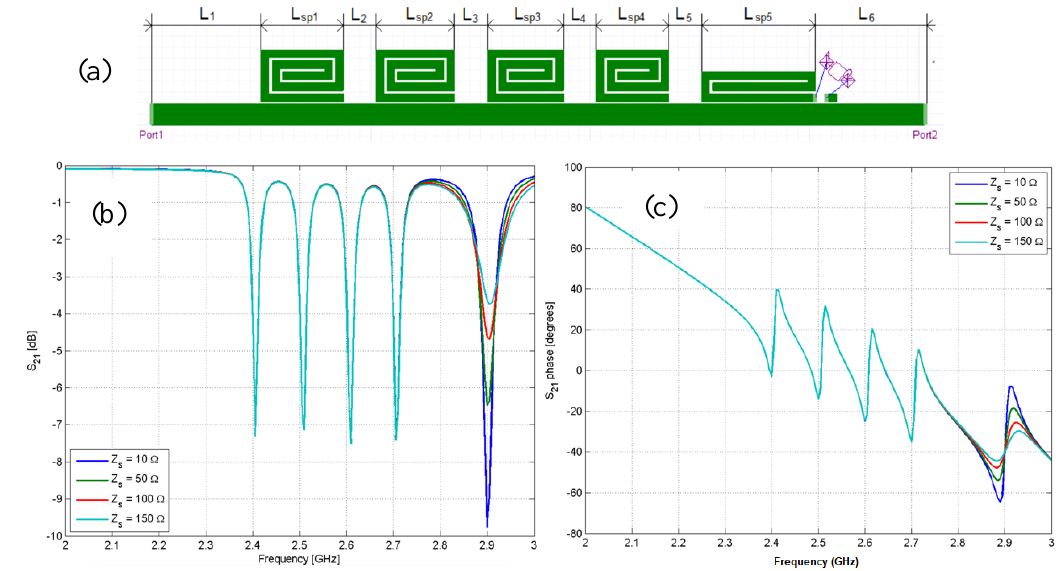
Figure 10. ( a ) Schema of a five-bit chipless tag equipped with a sensing element placed on the fifth resonator and a simulated five-bit chipless tag equipped with di ff erent resistors placed on the fifth resonator. ( b ) | S 21 | and ( c ) phase response.